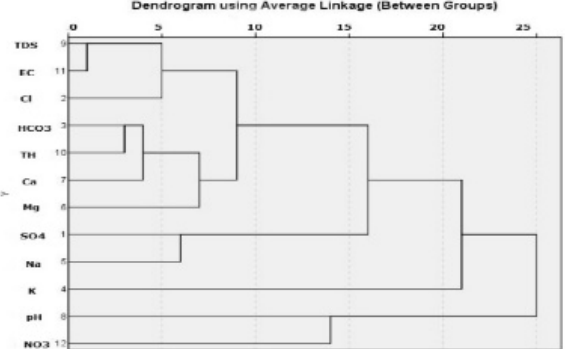
Fig. 6. The cluster diagram of the groundwater samples in the area